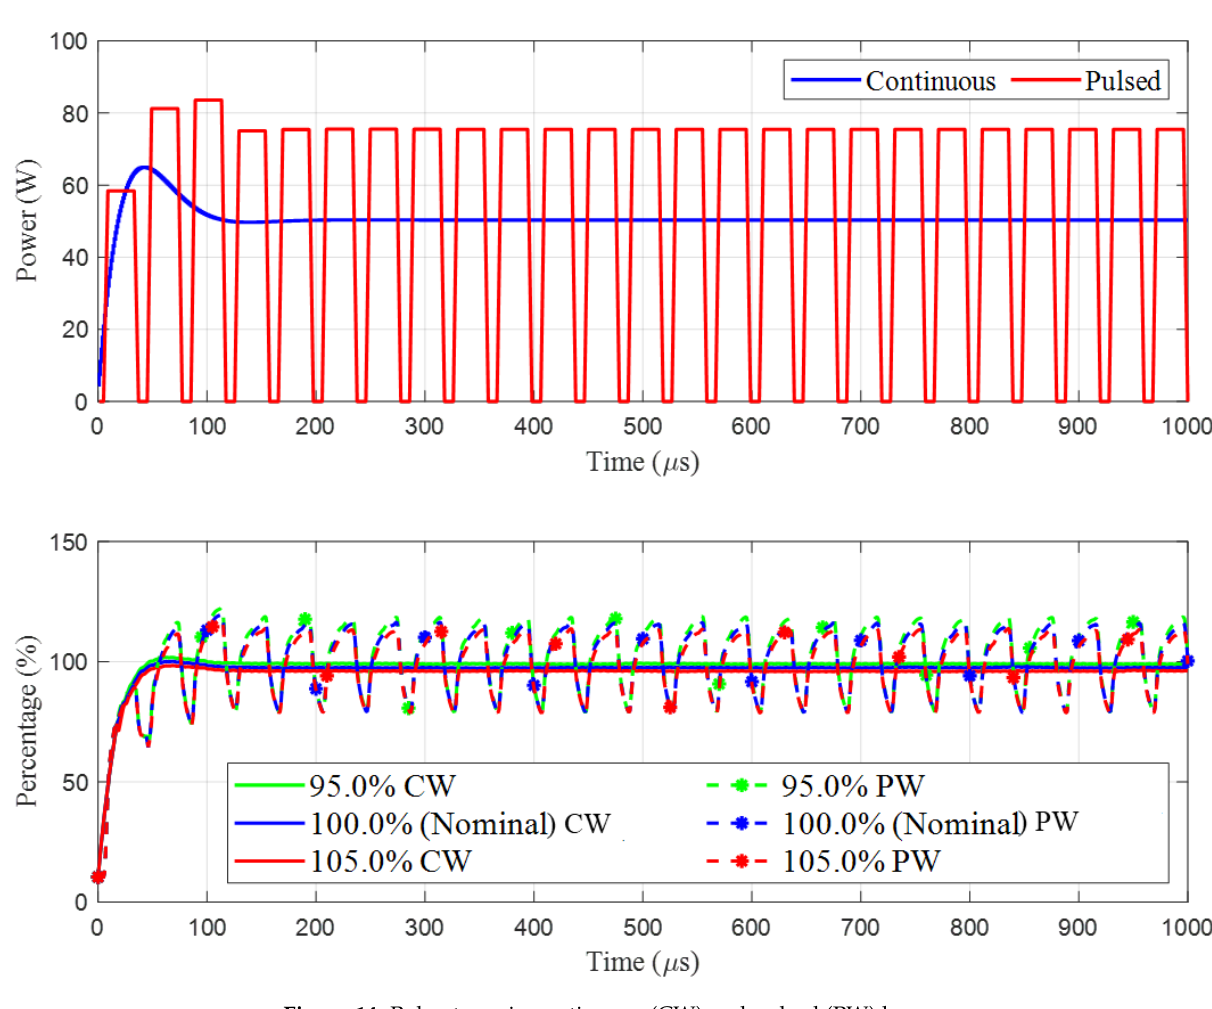
Figure 14. Robustness in continuous (CW) and pulsed (PW) laser.